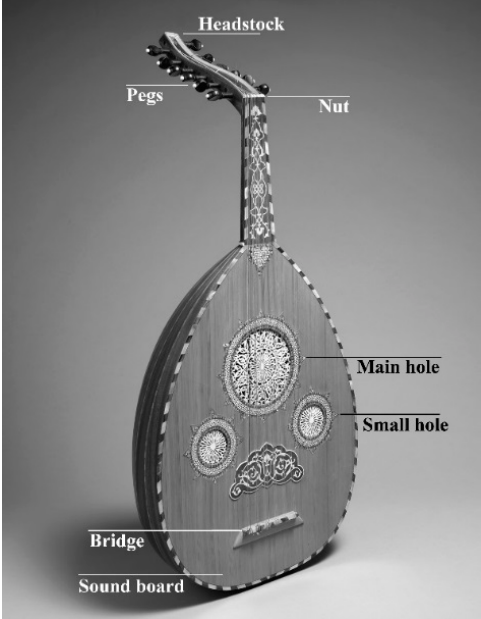
Figure 1. Elements of a typical lute.